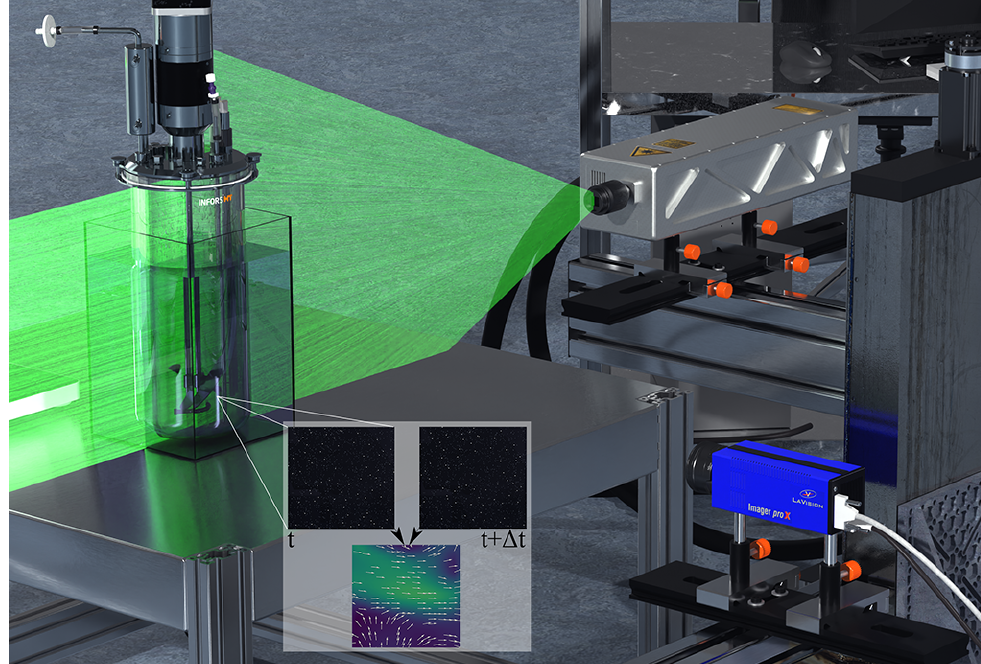
Figure 3. The figure shows a computer generated image (CGI) of the PIV system used. The investi- gated stirred bioreactor is placed in the centre of the measuring system. To minimise light refraction at the curved bioreactor wall, the bioreactor was placed in a rectangular, water-filled container. The bioreactor internals were coated in black to minimise reflection. At the top right of the figure, the double-pulse Nd:YAG laser can be seen as it emits a light pulse with a wavelength of 532nm (green light). With the high-sensitivity camera at the bottom right, which is aligned at a 90° angle to the light field, two images are recorded with a ∆ t time interval. The recorded images are shown in the centre of the figure for the time t and t + ∆ t . For each position, 1000 double images were evaluated and assembled into a two-dimensional vector field by means of